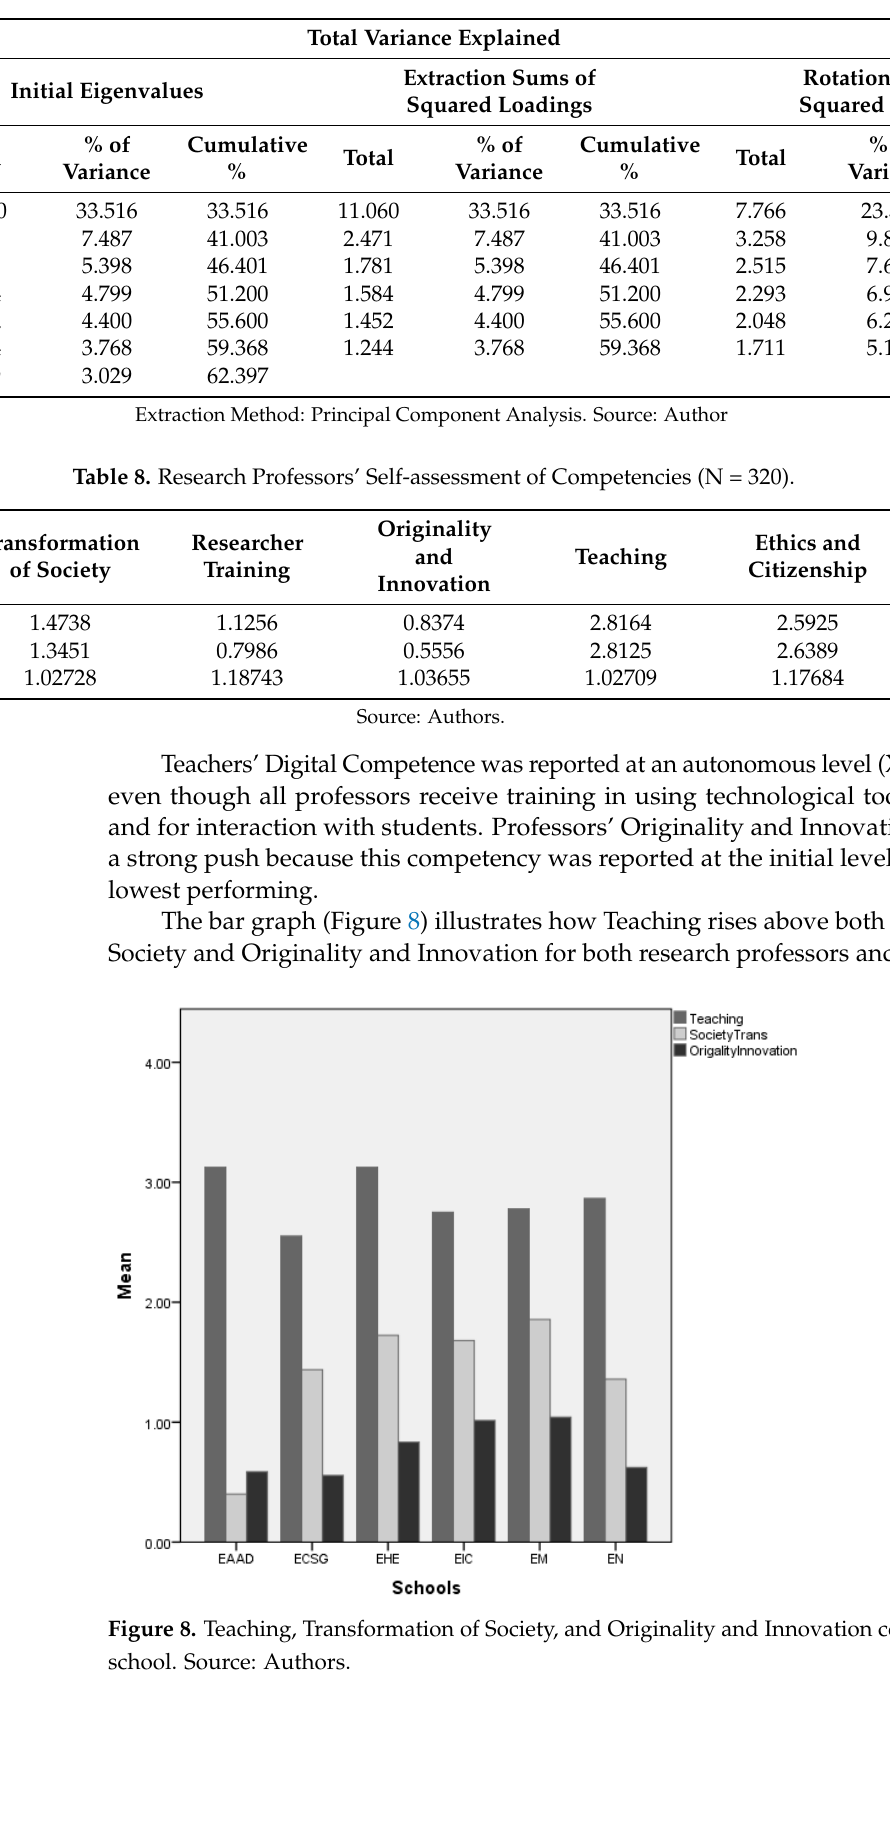
Table 7. Competencies’ Performance Variance as Reported by Research Professors.